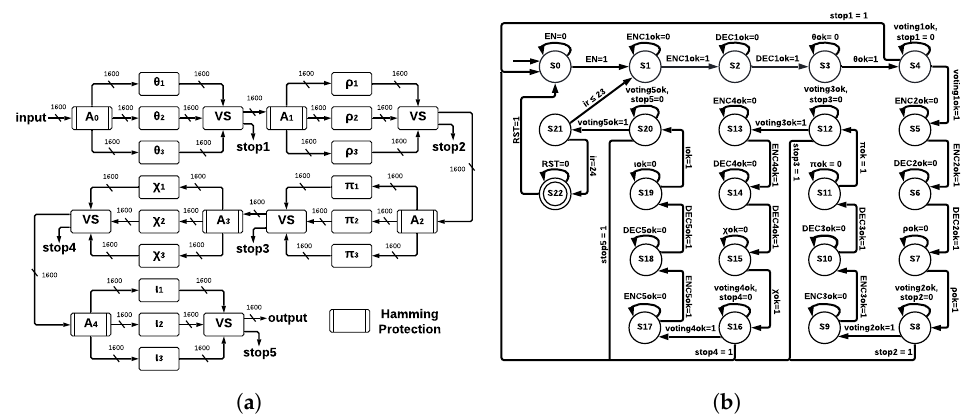
Figure 9. ArchTMR_HC at Round level and ArchTMR_HC state machine at KECCAK-p level. ( a ) ArchTMR_HC at Round level. ( b ) ArchTMR_HC state machine at KECCAK-p